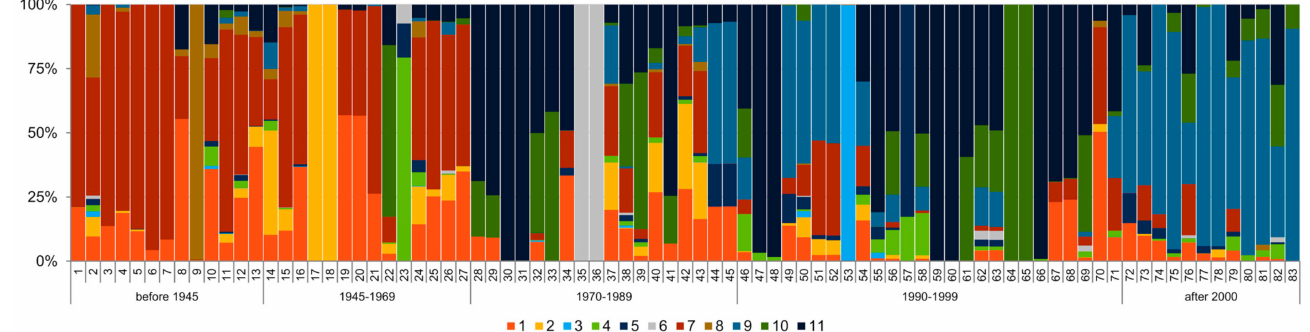
Figure 9. The results of 100,000 iterations of STRUCTURE software [22] for 83 spring barley cultivars based on DArTseq-derived SNPs data with K values K = 11 based on ad hoc measure ∆ K [23,24], where K is the number of ad hoc clusters; each vertical bar represents one cultivar that is marked by order number according to Table 6. The length of the colored segment shows the estimated proportion of membership of each gene pool in the cultivar genetic